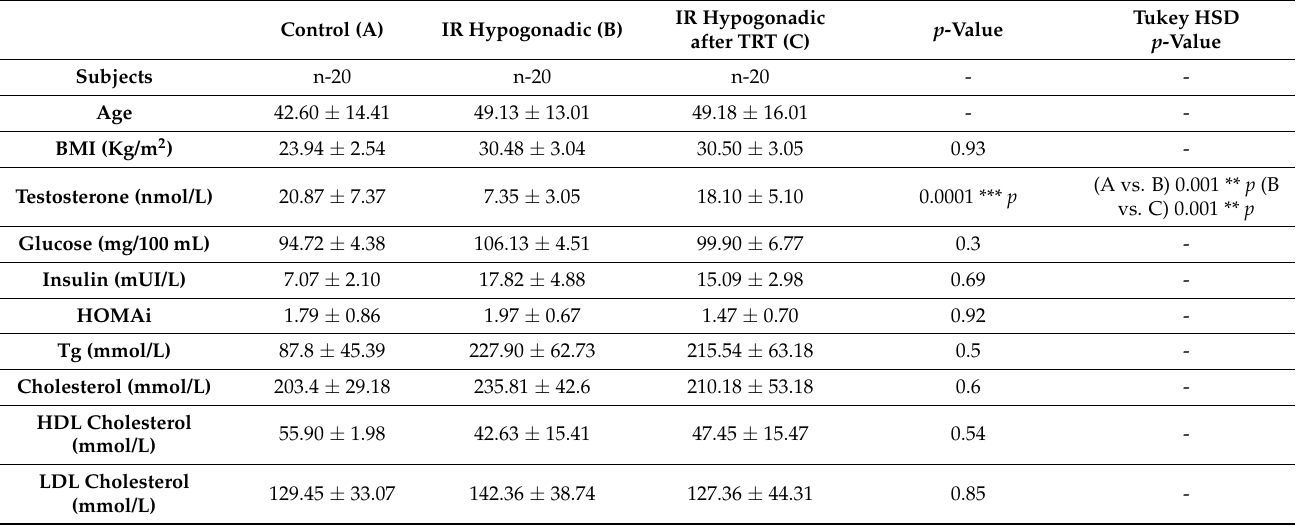
Table 1. Characteristics of study participants. BMI: body mass index, TG: triglycerides, LDL: low- density lipoprotein, HDL: high-density lipoprotein. Data are presented as the mean ± SD. Statistical differences were determined using Tukey’s multiple comparisons. ** p < 0.01, *** p <